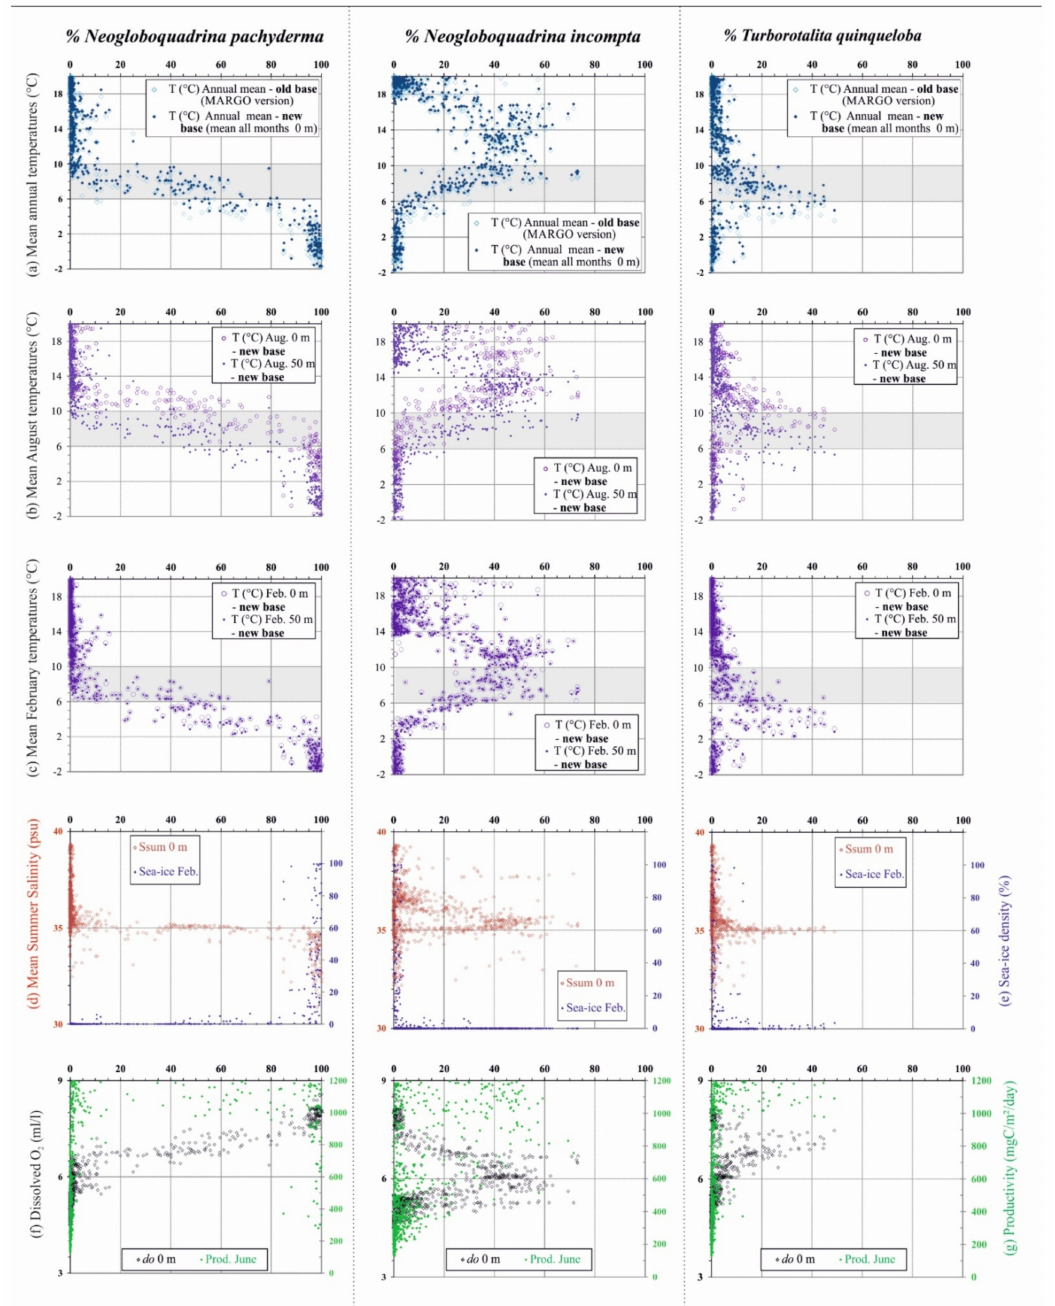
Figure 2. Distribution plots of some significant PF species (from left to right: Neogloboquadrina pachyderma , Neogloboquadrina incompta and Turborotalita quinqueloba ) from the North Atlantic subpolar assemblages with regard to their relative abundance in modern surface sediments (% in the >150 µ m fraction, X axis) and to selected hydrographical parameters (Y axis) that were newly included in the updated 1007 database. The first three top series of plots document the PF distribution with regard to temperatures from the new 1007 database with ( a ) a comparison of respective annual means extracted with the previously used database (based on MARGO [24], empty light blue circles) and the new one (dark blue circles), showing the good coherency between the two versions; ( b ) mean August (the warmest month of the year in the Northern Hemisphere) temperatures at two depths (0 m and 50 m); ( c ) mean February (the coldest month of the year in the Northern Hemisphere) temperatures at two depths (0 m and 50 m). Graphs ( a – c ) show that the summer stratification can be detected with the